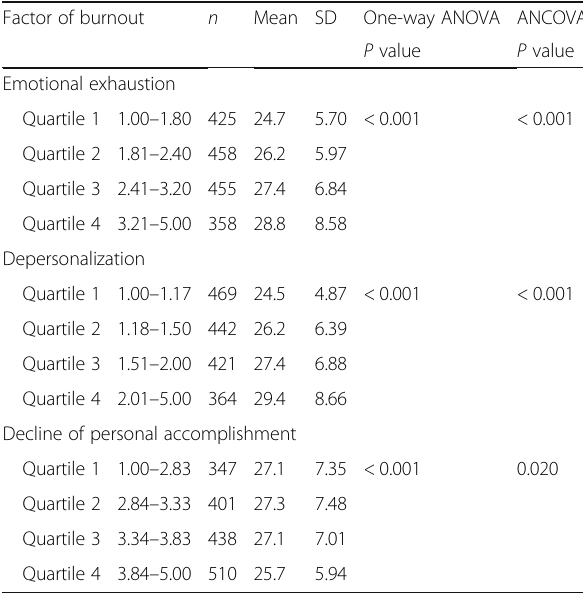
Table 3 Internet Addiction Test scores by quartile of each factor of burnout Factor of burnout